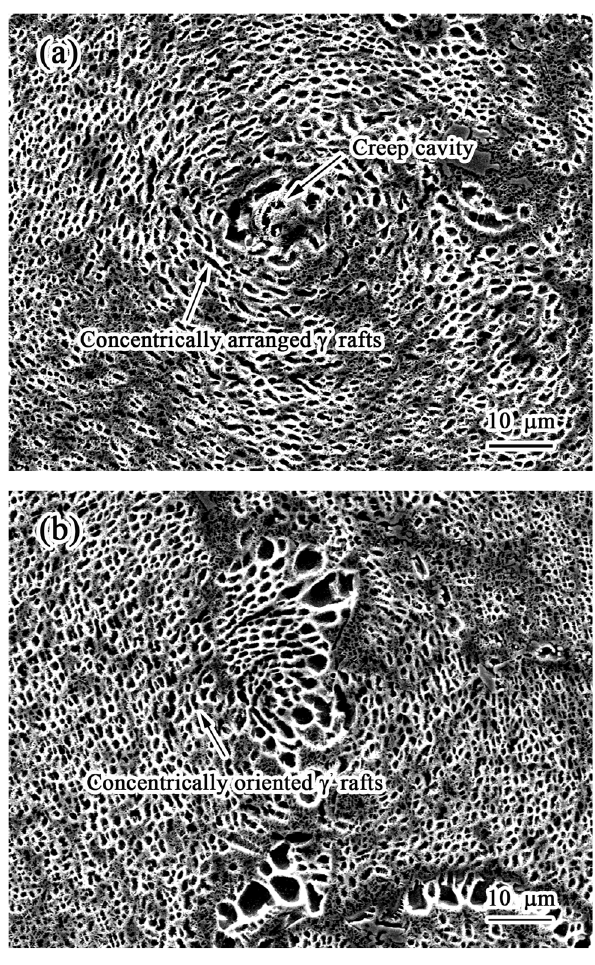
Figure 5: Concentrically oriented γ ′ raft structure near the creep- induced cavity under HIP condition of 1,190°C/200 MPa/4 h. (a) Creep cavity can be observed; (b) creep cavity cannot be